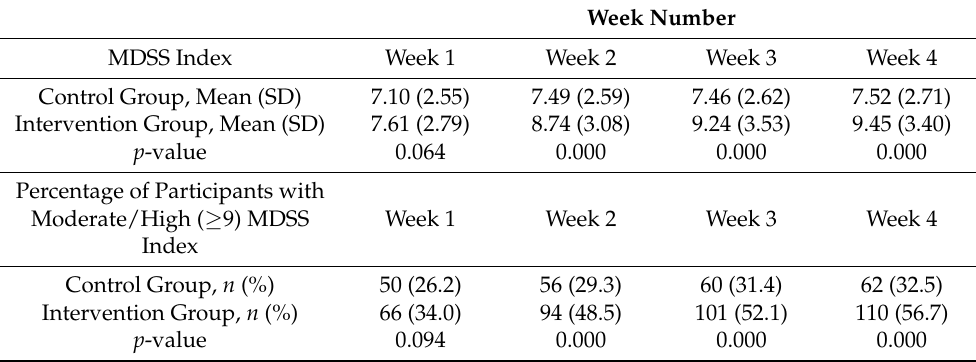
Table 2. Mediterranean Diet Serving Score (MDSS) Index and Percentage of Participants with Moderate/High ( ≥ 9) MDSS Index Throughout the Four Weeks of Follow-Up in the Whole Study